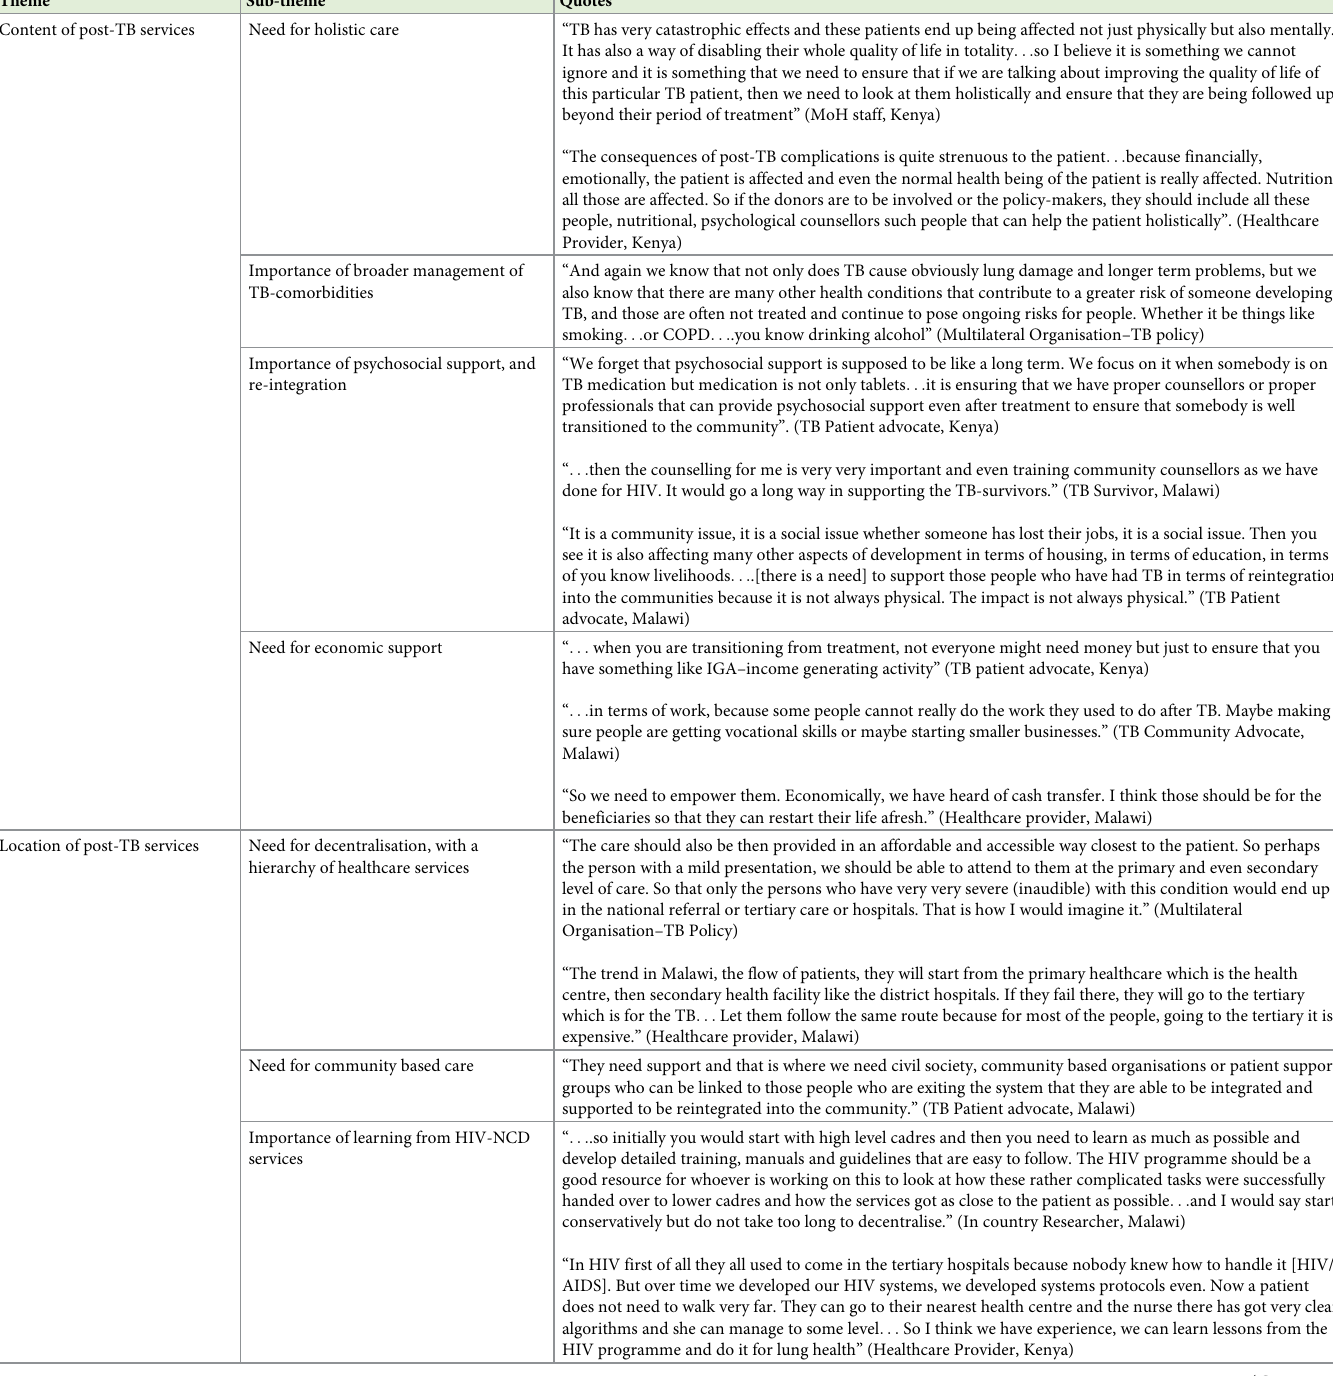
Table 3. Direct participant quotes: Structure and delivery of post-TB care